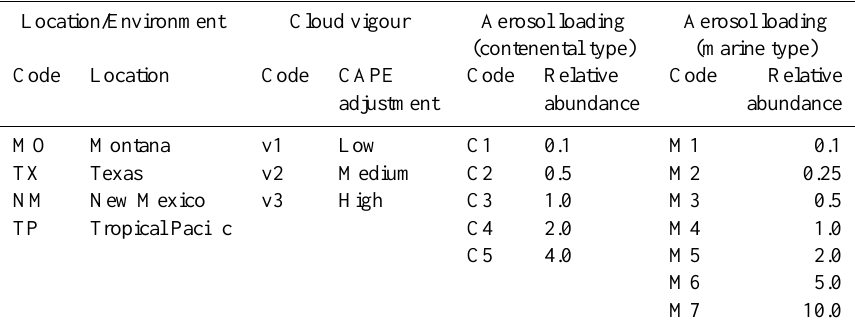
Table 1. Naming convention used in this paper. For example, NM-v3-aerC1 is a run using the New Mexico profile adjusted to give high CAPE and using the lowest continental aerosol loading. Aerosol loading refers to the relative number concentration of particles in the accumulation mode for continental simulations or in the accumulation and coarse modes in marine runs.